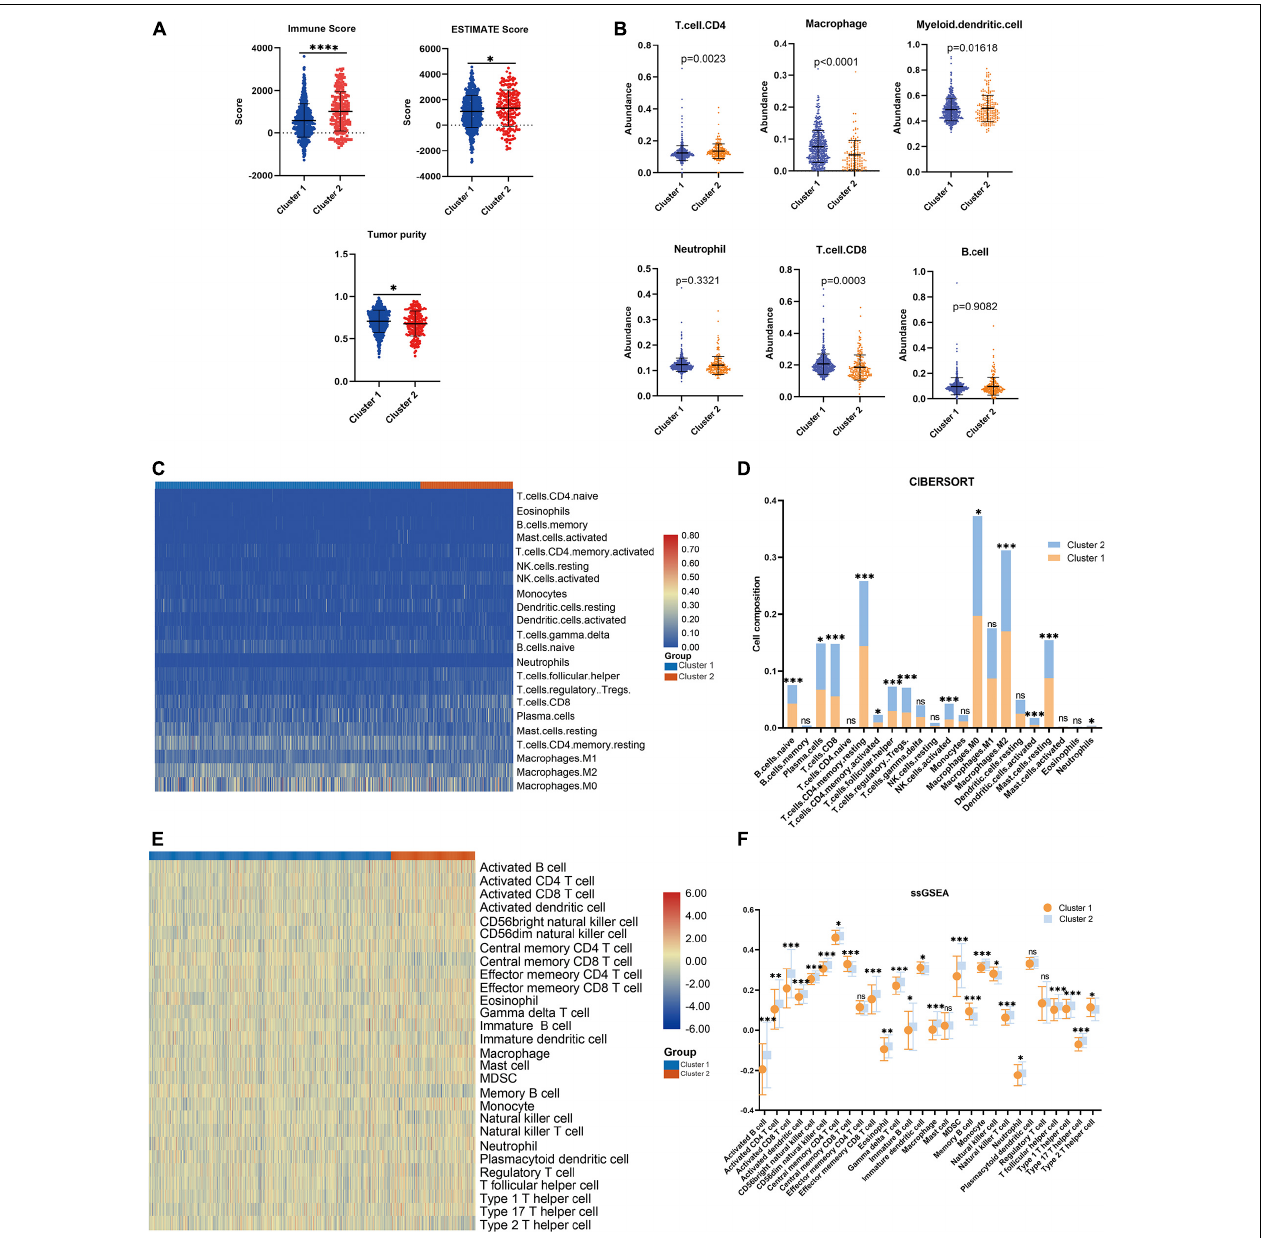
FIGURE 3 | Immune analyses in the clustered subgroups. (A) ESTIMATE algorithm, (B) TIMER algorithm, (C,D) CIBERSORT analysis, and ssGSEA analysis (E,F) . * p < 0.05, ** p < 0.01, *** p < 0.001, **** p <